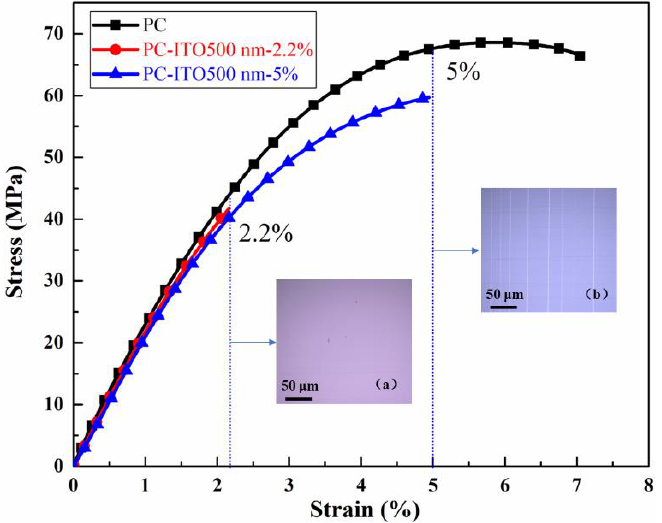
Figure 2. Stress–strain curves of PC substrate and ITO film on PC. Illustrations are surface topography of 500 nm ITO film after unloading: ( a ) Stretched to 2.2% strain; ( b ) stretched to 5% strain.